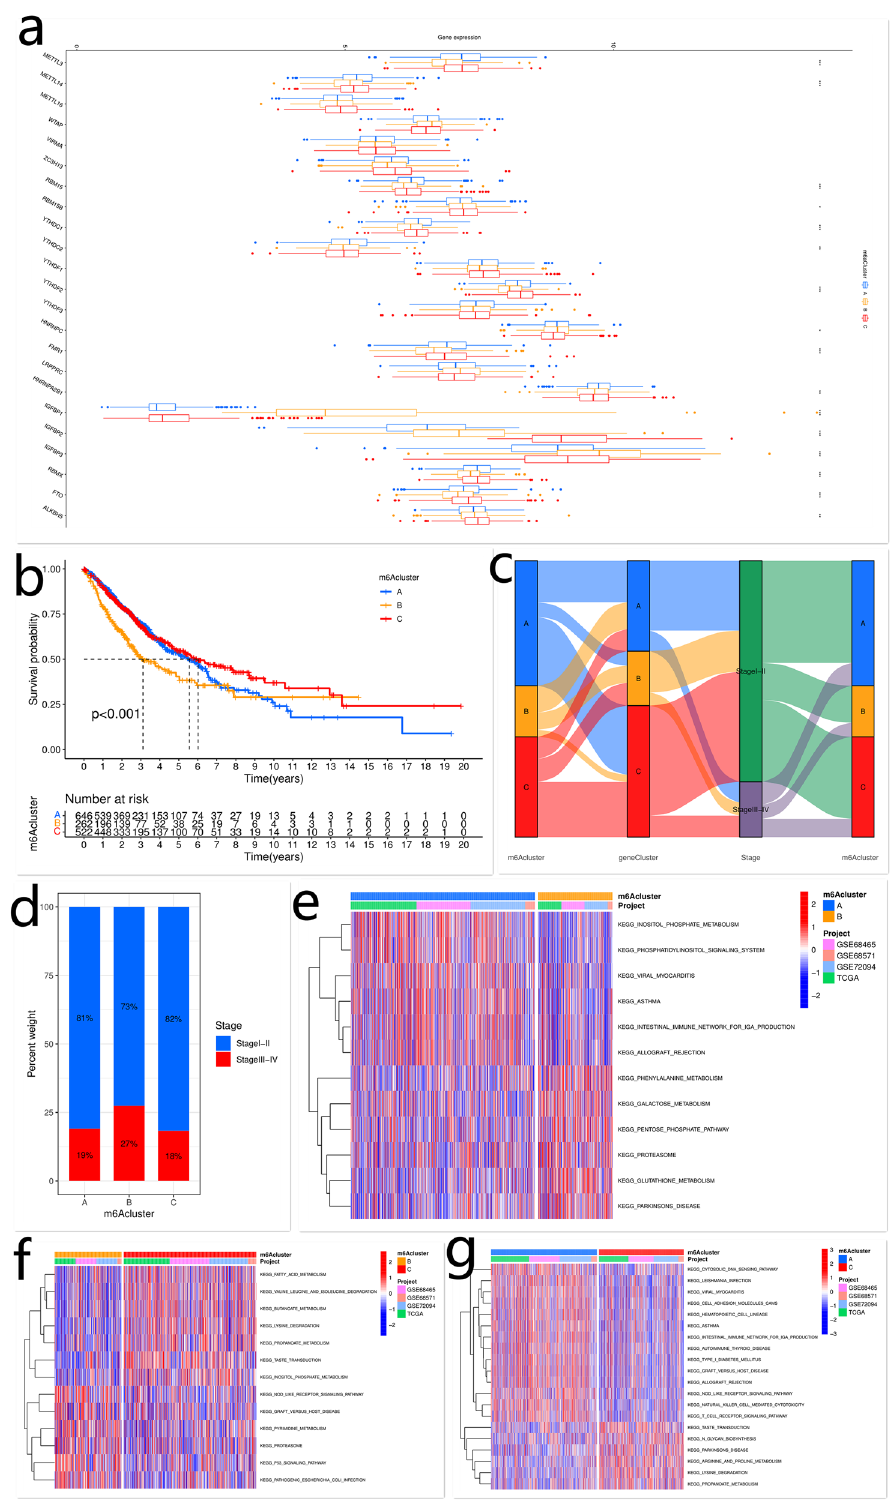
Figure 2. The expression of m6A regulators, clinical characteristics of LUAD patients, and biological processes in different m6A modification-related patterns. The expression of m 6 A regulators in different m 6 A modification- related patterns ( a ). The Kaplan–Meier curves of the OS of LUAD patients with different m 6 A modification- related patterns ( b ). The relationships among m 6 Acluster, m 6 A genecluster, and stage were visualized using alluvial diagram ( c ). The percentage of patients with stage I, II/III, and IV LUAD in each m 6 Acluster ( d ). The biological processes in different m 6 A modification-related patterns. Red indicates activation, while blue indicates inhibition ( e , f , g ). This figure is created using the R (version 4.0.3) (https:// www.r- proje ct.